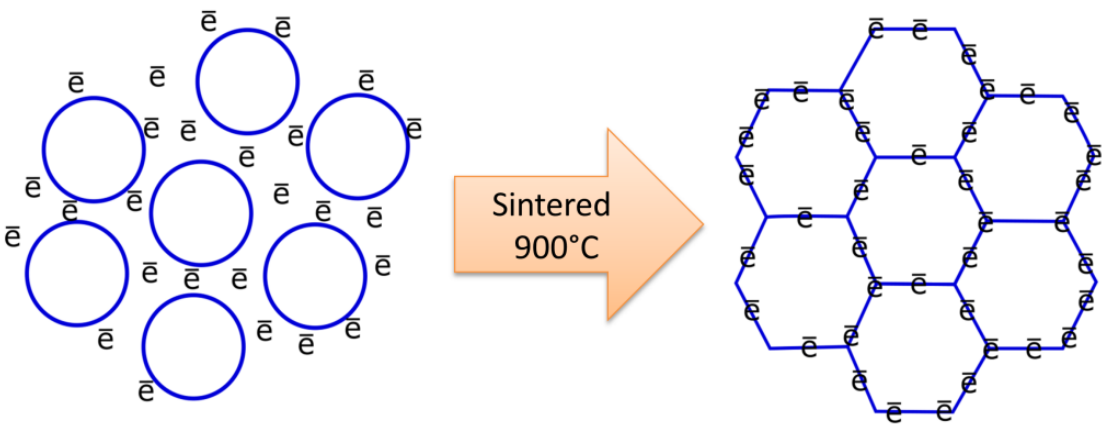
Figure 7. Proposed electron pathway at the crystalline grains structure at 900 °C sintering temper- ature.